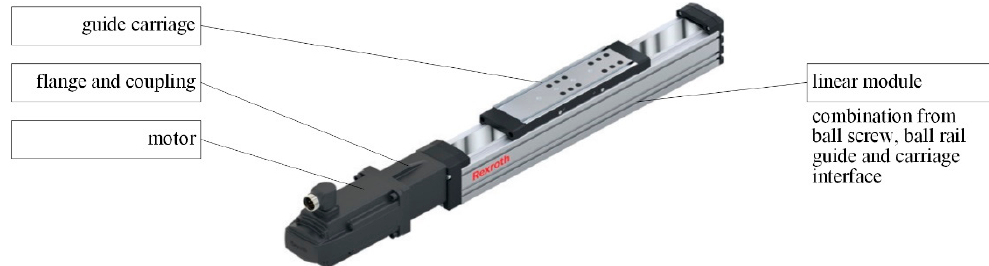
Figure 5. “Linear drive axle MKK-040 with synchronous servomotor MSM019B” [15]—the object of investigations.